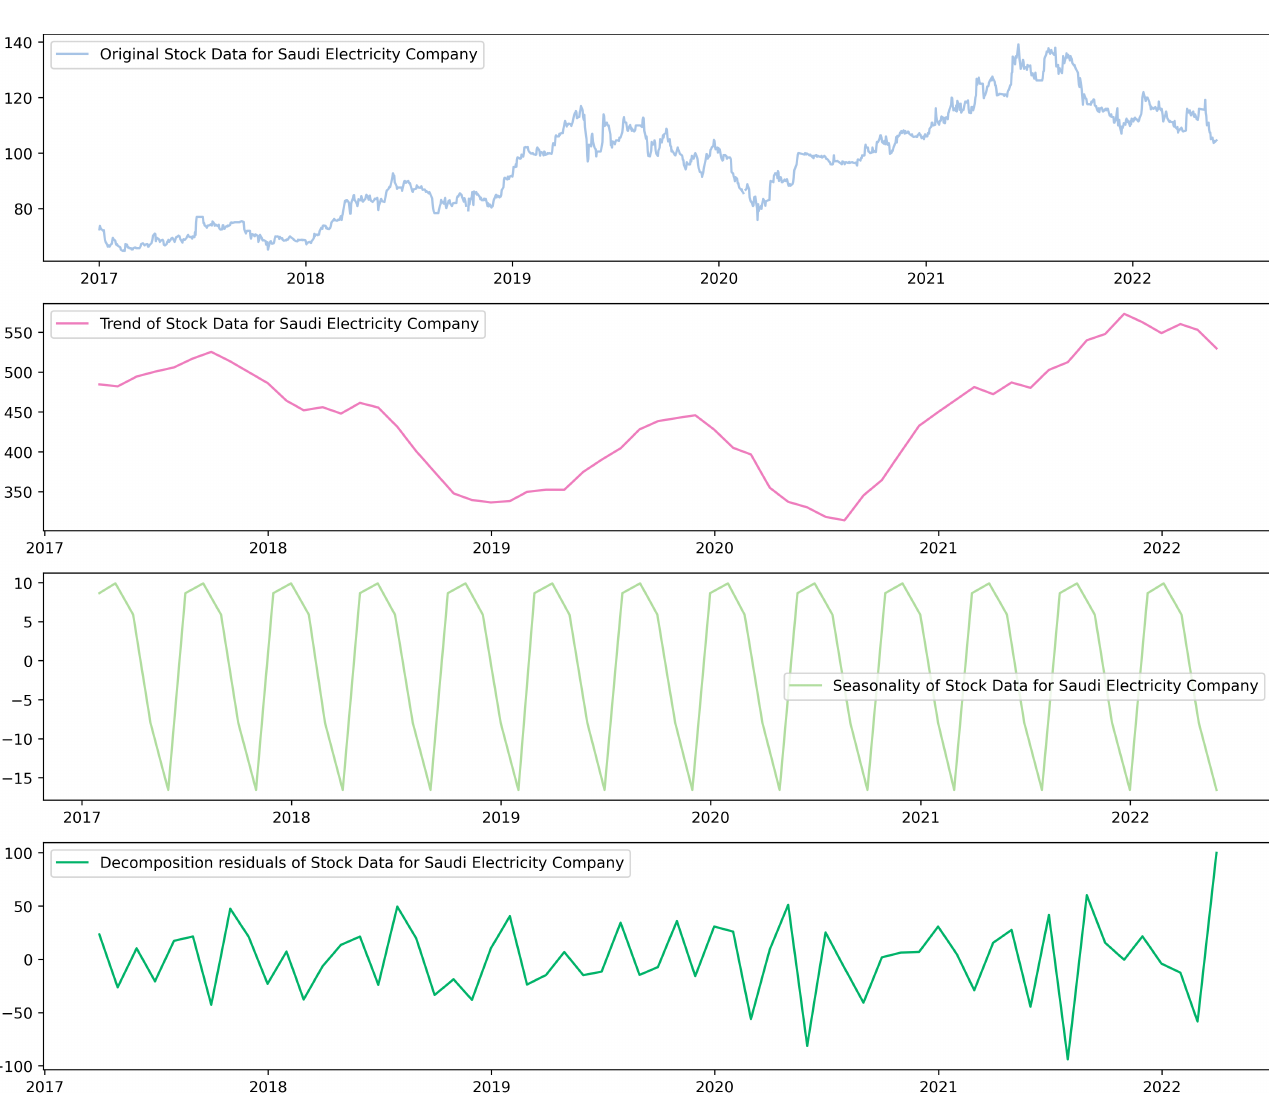
Figure 10. Decomposition of 5110 Stock Data: Trend, Seasonal (Periodic), and Residual